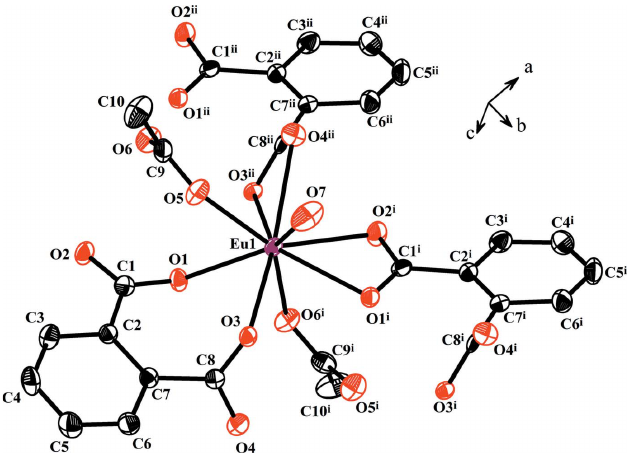
Figure 2 Extended asymmetric unit of the title compound drawn using 50% probability for ellipsoids (hydrogen atoms are omitted for clarity). Symmetry codes: (i) 3